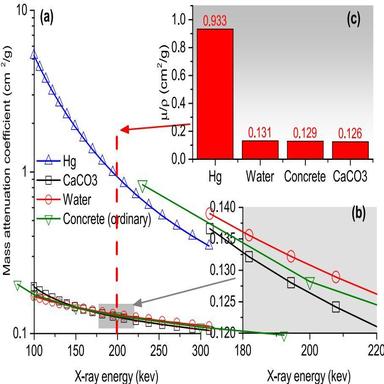
(a) X-ray MACs of mercury, ordinary concrete, water (liquid) and CaCO3 versus X-ray beam energy, (b) the MACs of ordinary concrete, water and CaCO3 in the X-ray beam energy interval between 180 and 220 keV, and (c) the comparison of the MACs among mercury, ordinary concrete, water and CaCO3 at the very X-ray beam energy of 200 keV applied in this study.